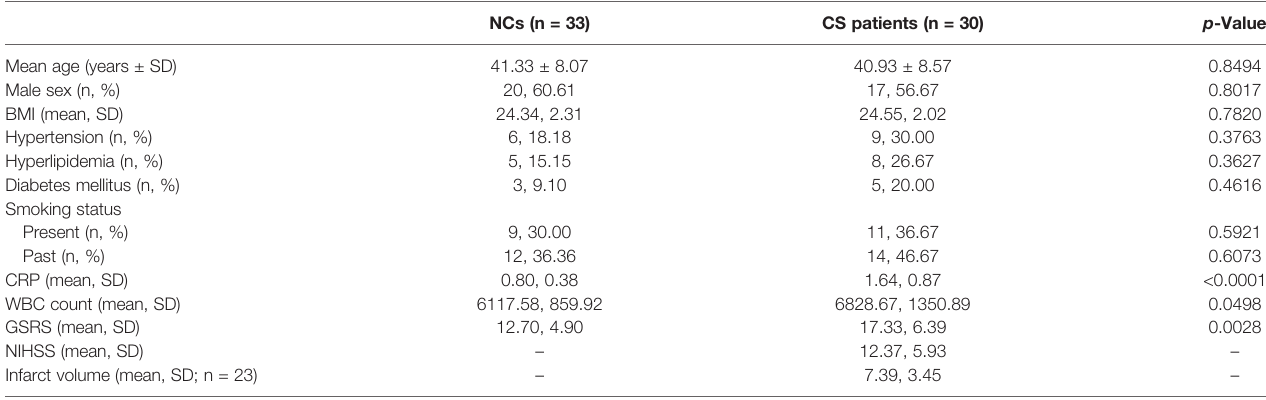
TABLE 1 | Characteristics of the study